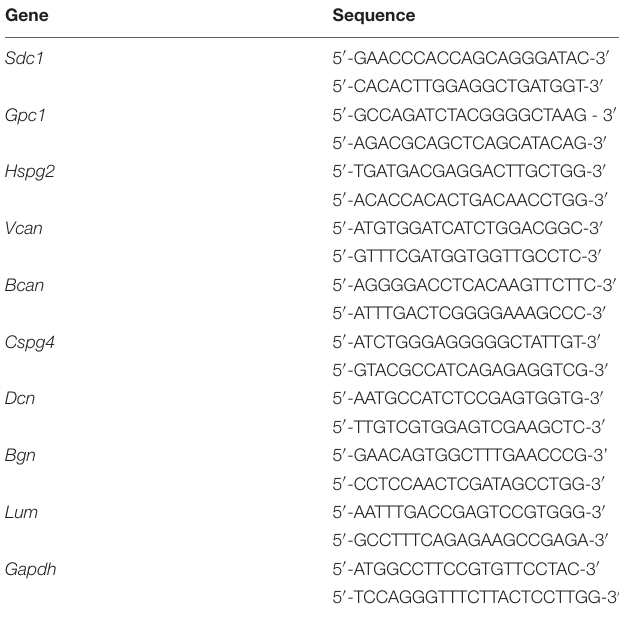
TABLE 1 | Sequences of primers used in PCR analysis. Gene